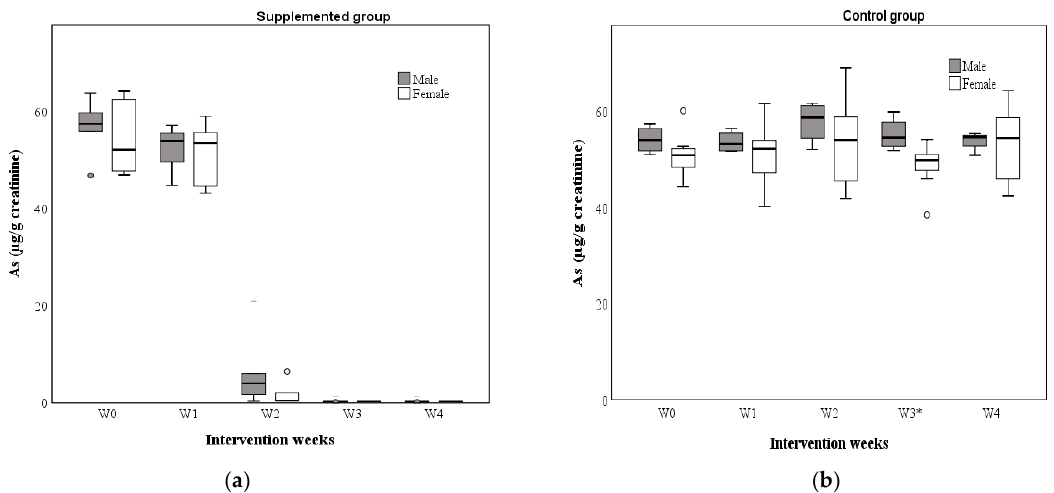
Figure 3. UAs (Urinary arsenic) (median) concentration by sex in the supplemented group ( a ) and control group ( b ) (W0: baseline; W1: week 1; W2: week 2; W3: week 3; W4: week 4). * Statistically significant difference by sex according to the Mann – Whitney U test ( p < 0.05).